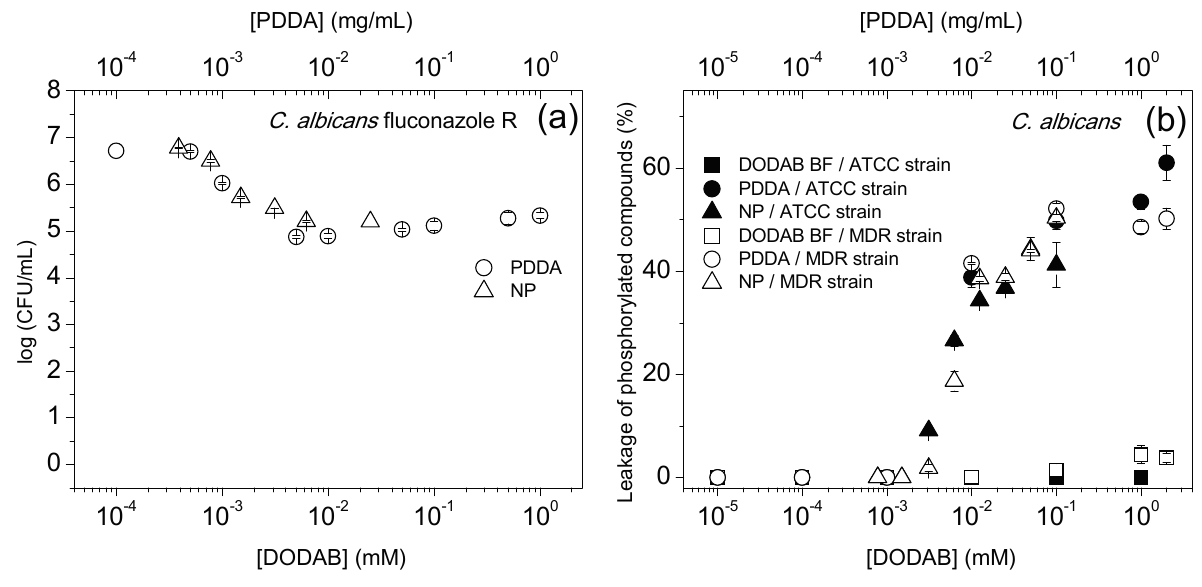
Figure 3. ( a ) The logarithm of CFU/mL as a function of DODAB or PDDA concentrations for the C. albicans fluconazole-resistant (R) strain at 5–6 × 10 6 CFU/mL; ( b ) percentile of the leakage of phosphorylated compounds (%) as a function of DODAB or PDDA concentrations for C. albicans reference (ATCC) and resistant strains at 7 × 10 6 –1 × 10 7 CFU/mL. Interactions took place for 1